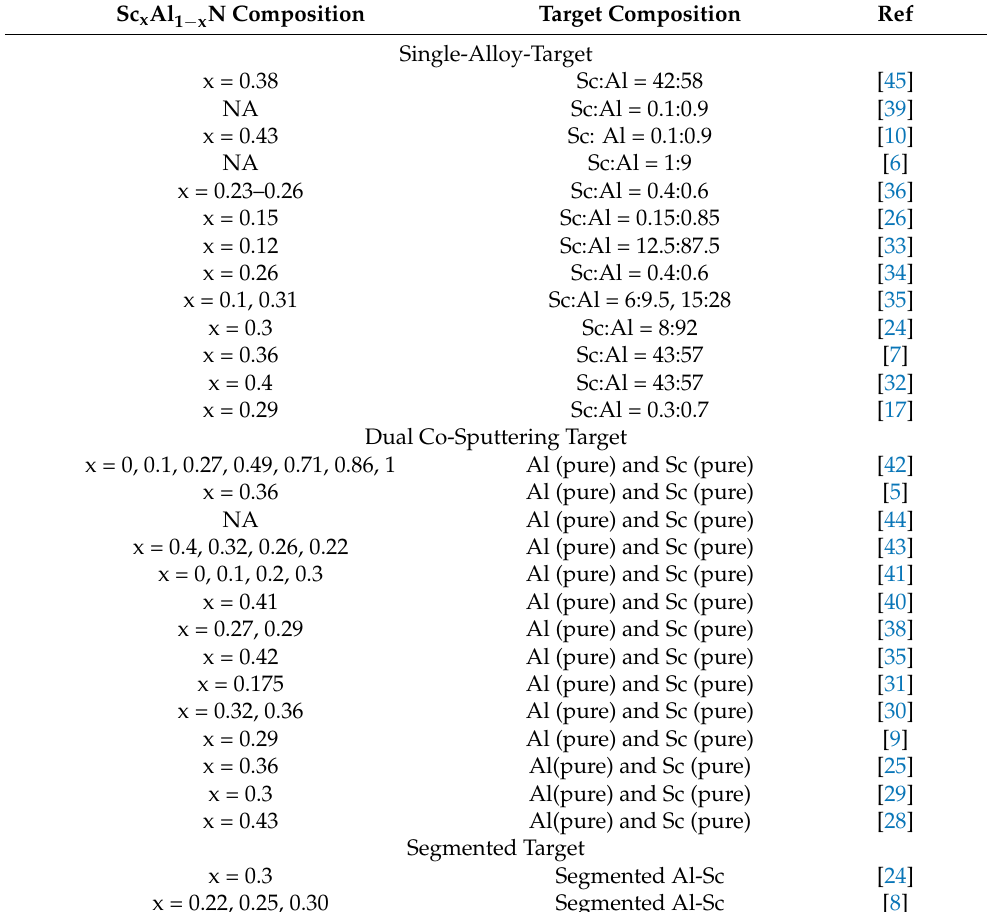
Table 3. Sc x Al 1 − x N films produced using various target